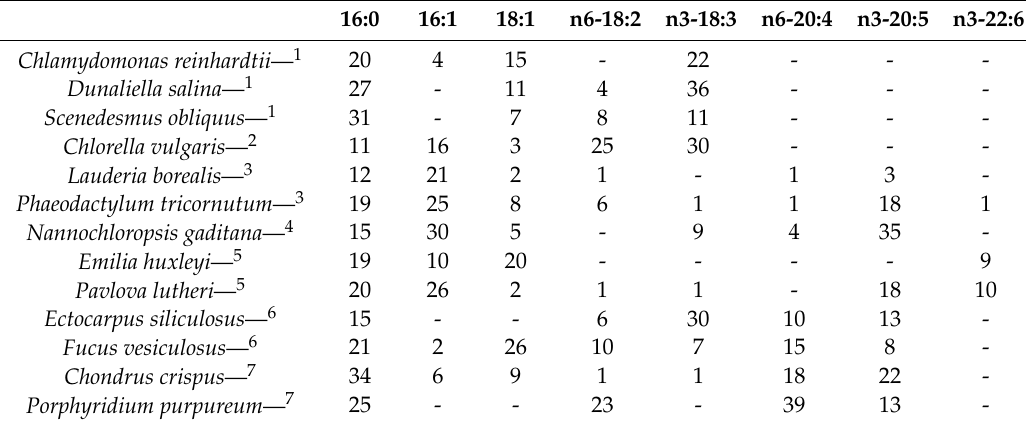
Table 2. Major fatty acids in a variety of freshwater and marine algae (data taken from